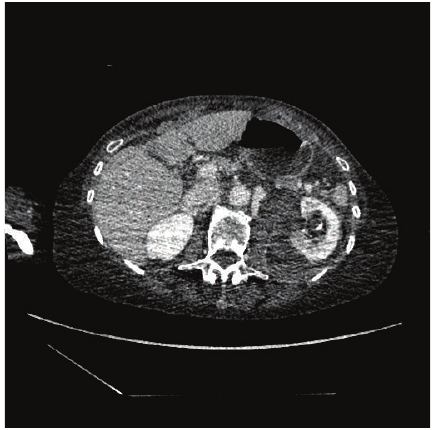
Figure 2: Split bolus contrast CT KUB: transverse section, left kidney.